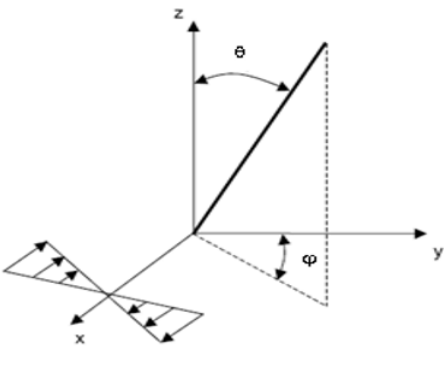
Figure 2. Coordinate system for a rod-like particle centered at the origin and subjected to a simple shear in the xy